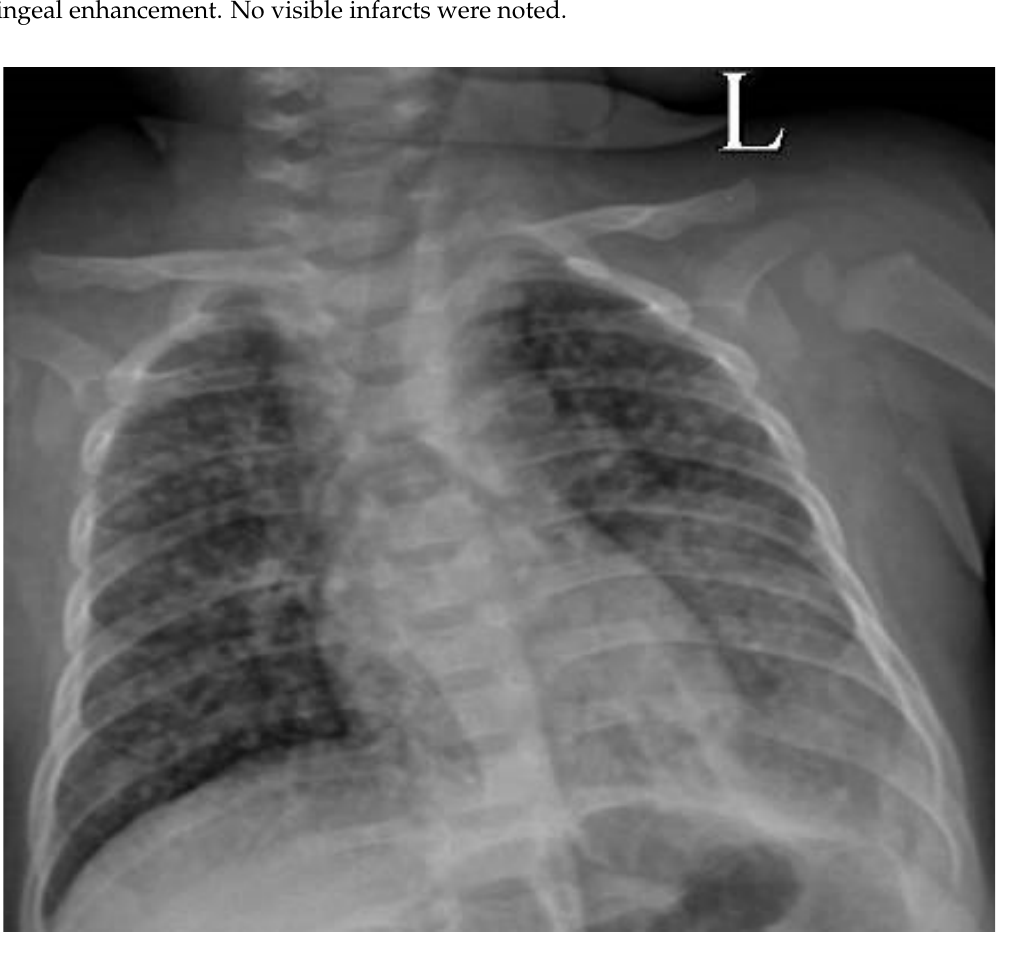
Figure 1. Chest radiograph on admission demonstrating bilateral nodular infiltrates (together with left lower lobe consolidation), suggestive of disseminated (miliary) tuberculosis.